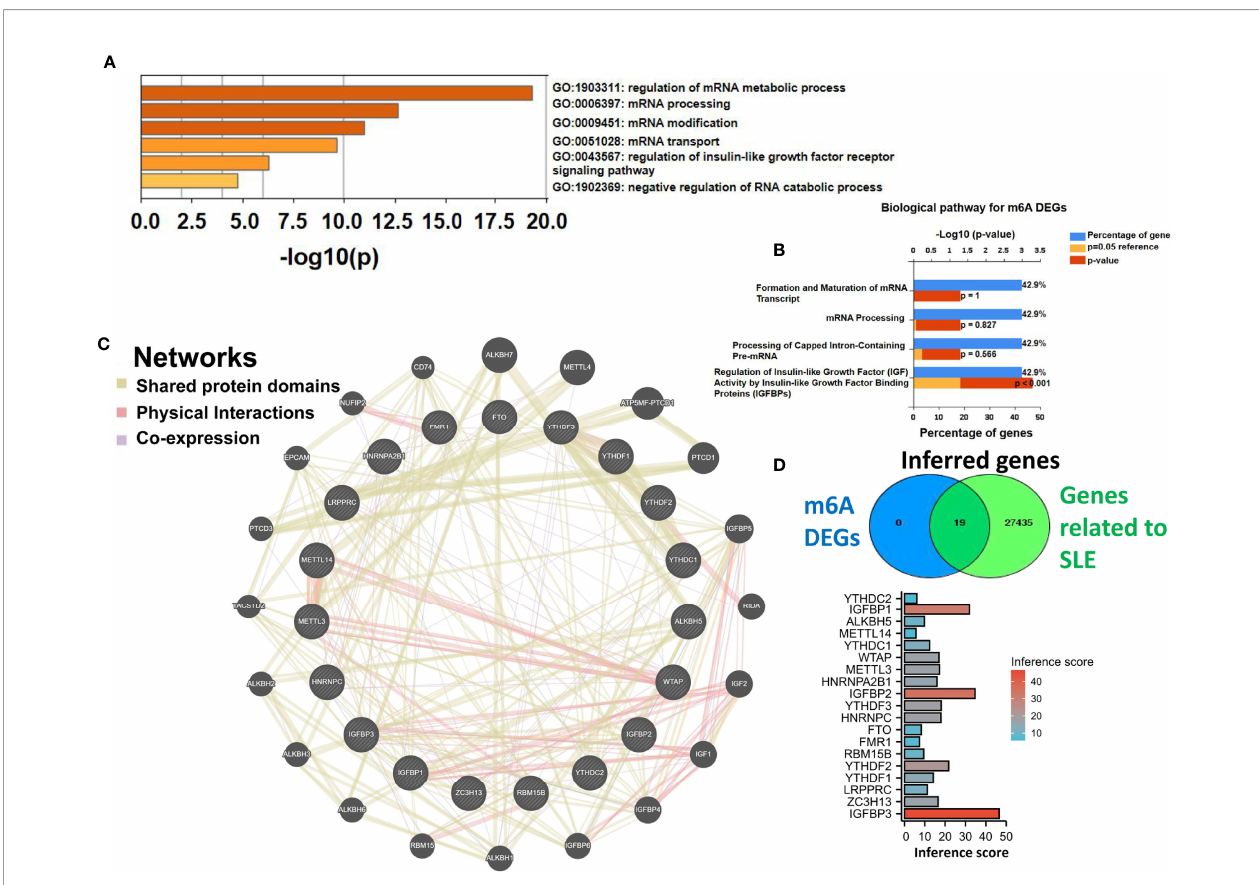
FIGURE 2 | GO, KEGG, gene – gene interaction network analyses, and relationship to SLE of m6A regulators. (A) Bar plot showing the GO analysis of the 19 identi fi ed m6A regulators based on Metascape online. (B) KEGG analysis of biological pathways (ranked by p-value). (C) The gene – gene interaction network of